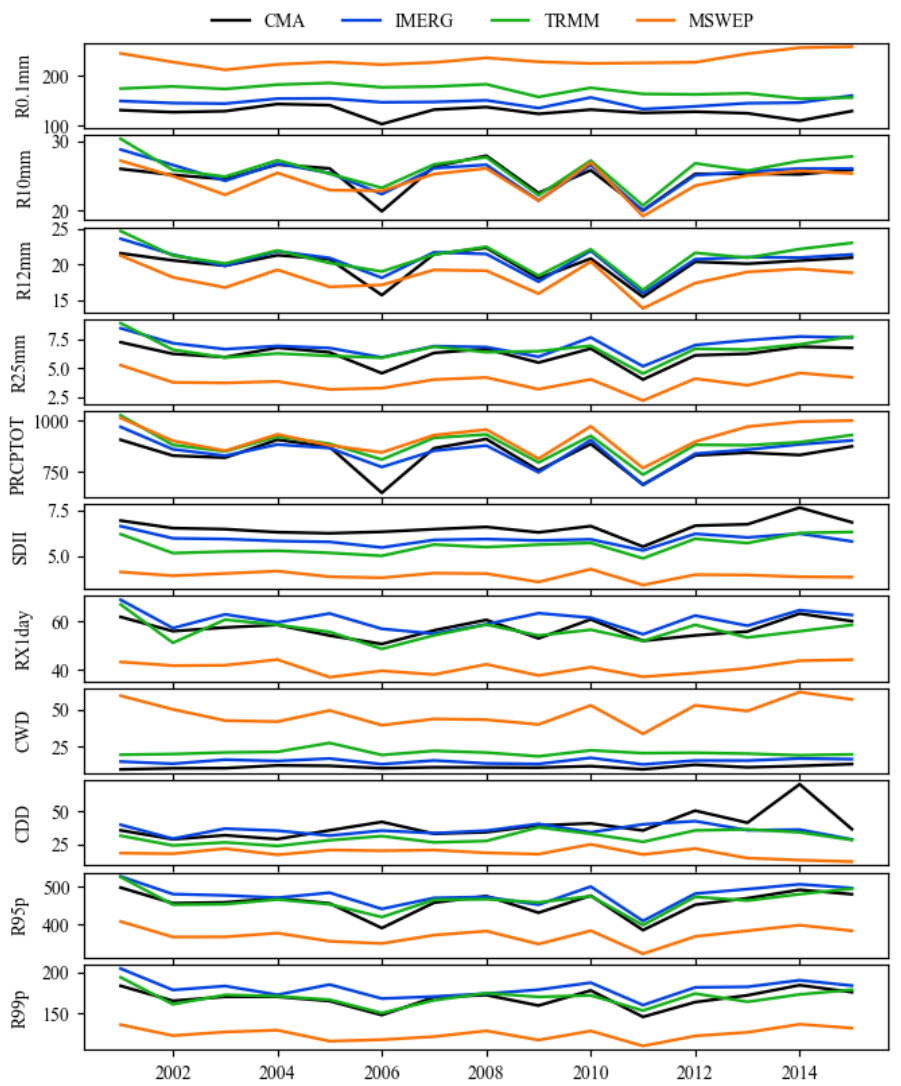
Figure 6. Mean extreme precipitation indices of the 62 rain gauge stations, and the corresponding IMERG, MSWEP, and TRMM estimates from 2001 to 2016.